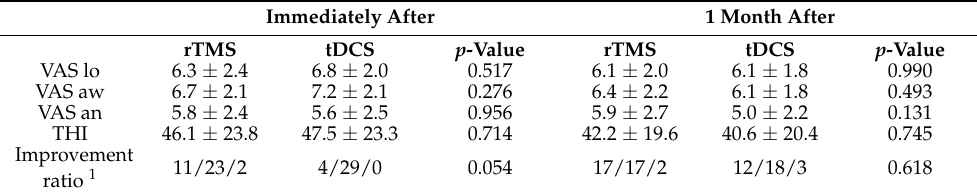
Table 2. Comparison of treatment results between rTMS and tDCS.